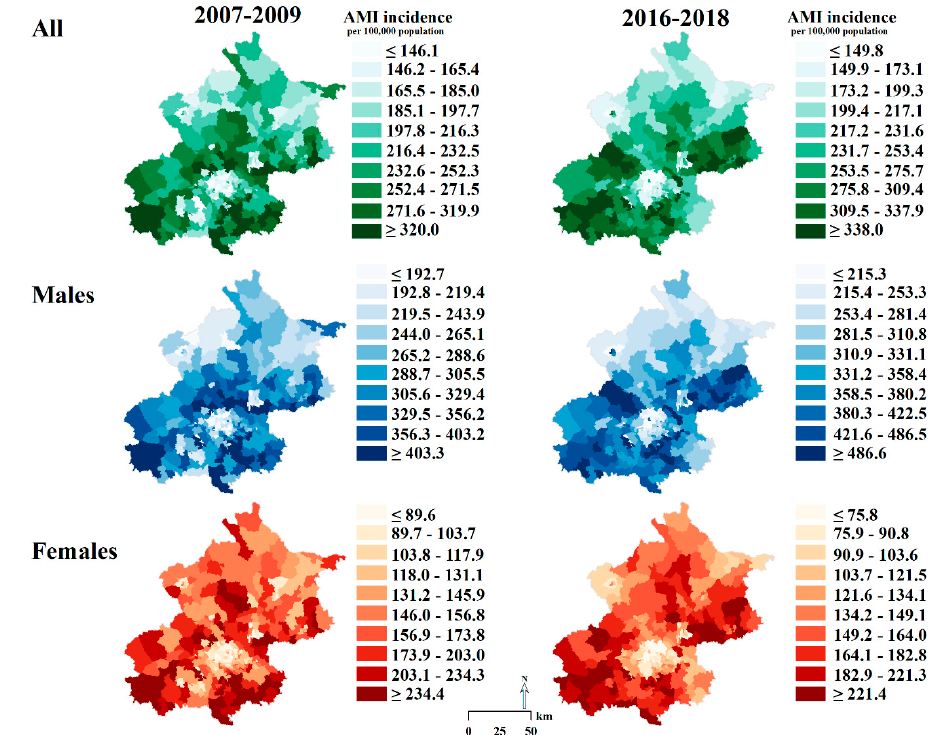
Figure 1. Deciles of the Age-Standardized Incidence of Acute Myocardial Infarction in Beijing Residents Aged ≥ 35 Years at the Township Level, 2007–2018. AMI indicates acute myocardial infarction.